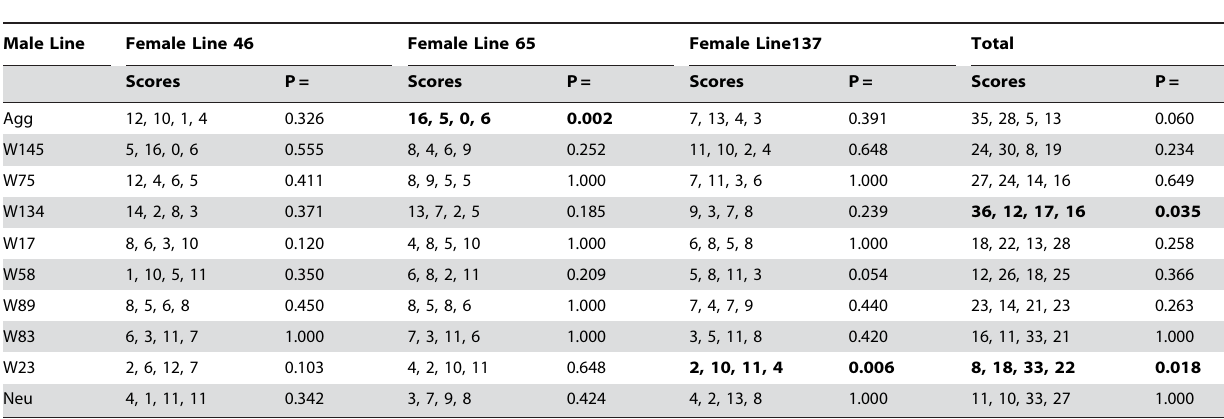
Table 3. Mating success in relation to territorial success and female